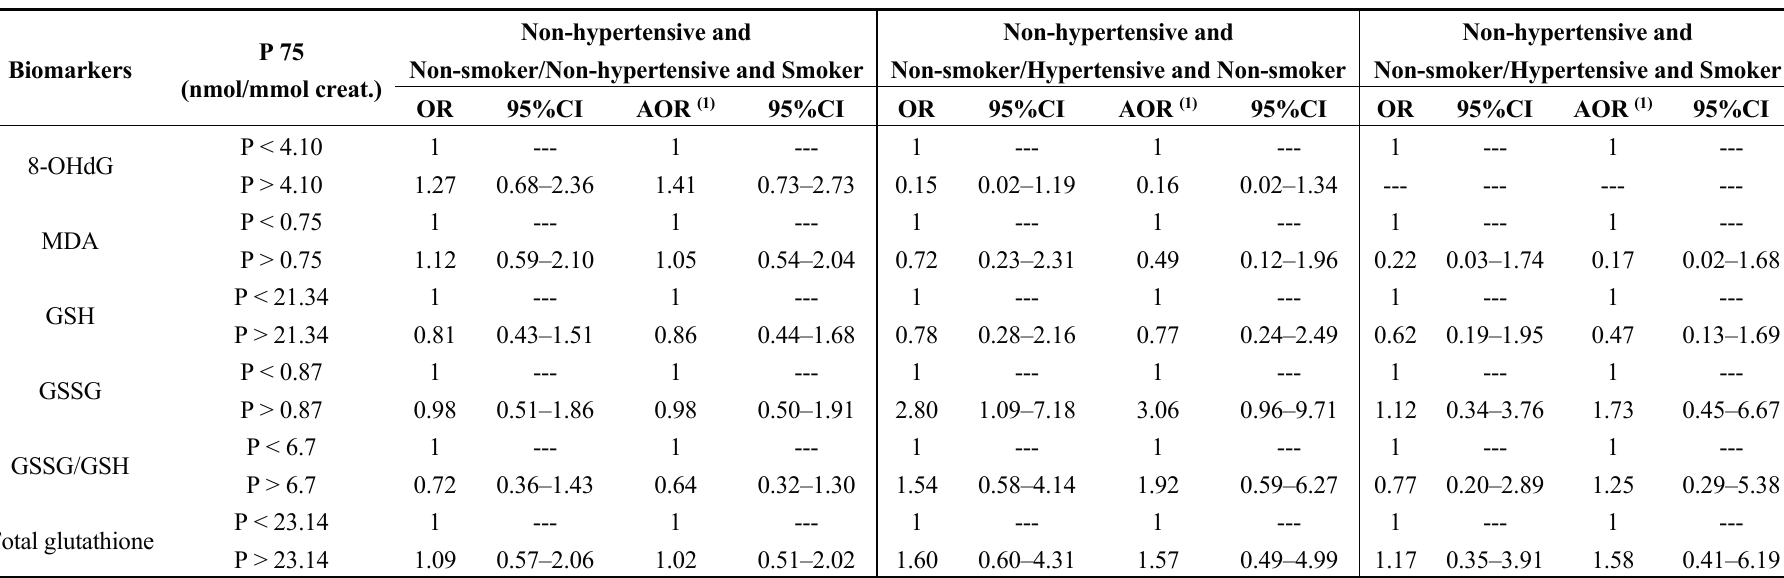
Table 5. Assessing the risk (OR) of oxidative stress markers in the non-hypertensive non-smoker population, in relation to: smoking, hypertension, and the combined effect of smoking and